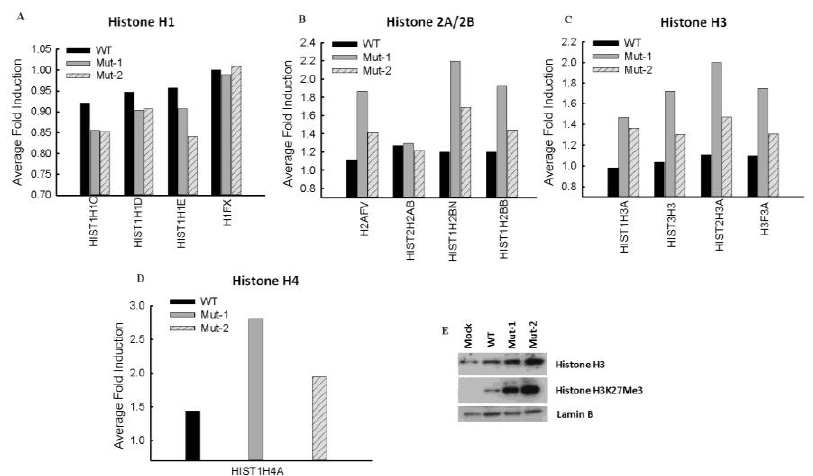
Figure 5. Changes in nuclear histone proteins in response to hMPV infection. Nuclear histone proteins were analyzed as described in the Supplementary Table S1. Motif-affected histone 1 ( A ), histone 2 ( B ), histone 3 ( C ), and histone 4 ( D ) are summarized and presented. The changes and methylation levels of histone 3 by hMPV were investigated by Western blot using antibodies against the indicated proteins with/without protein modification ( E ).